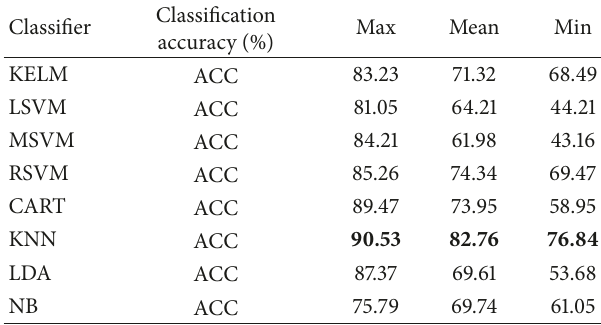
Table 2: Confusion matrix. Table 3: Results of comparative classifiers without SAE on Oxford